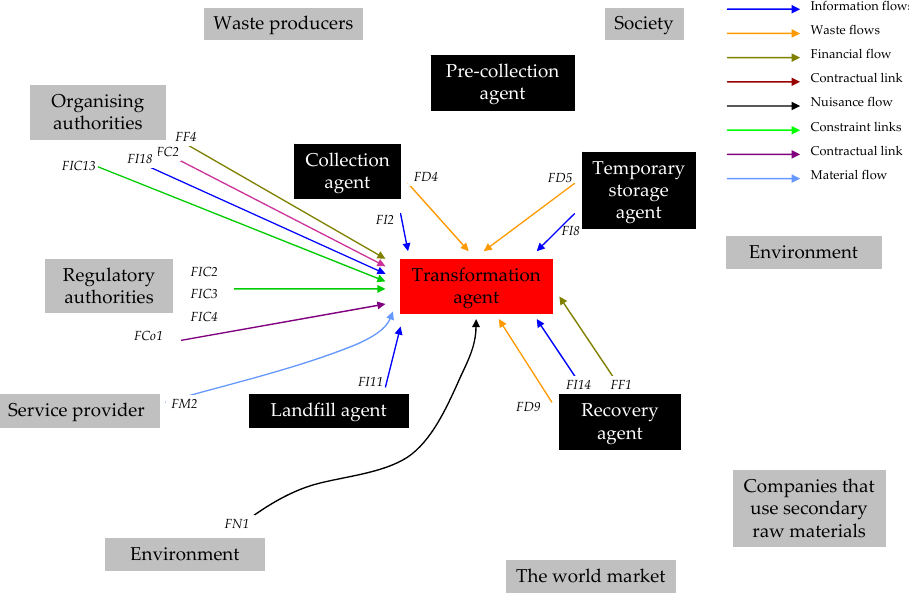
Figure 6 : The functional block diagram of relationships generated by ohter constituants 10 Fig. 6. The functional block diagram of relationships generated by other constituent elements toward a “ transformation agent ” elements toward « transformation agent » subsystem. 11